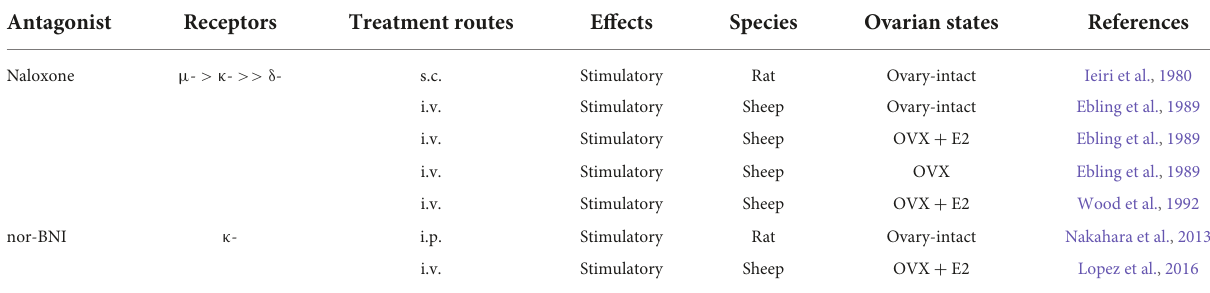
TABLE 5 Effects of opioid receptor antagonists on tonic luteinizing hormone (LH) secretion in pre-pubertal female mammals. Antagonist Receptors Treatment